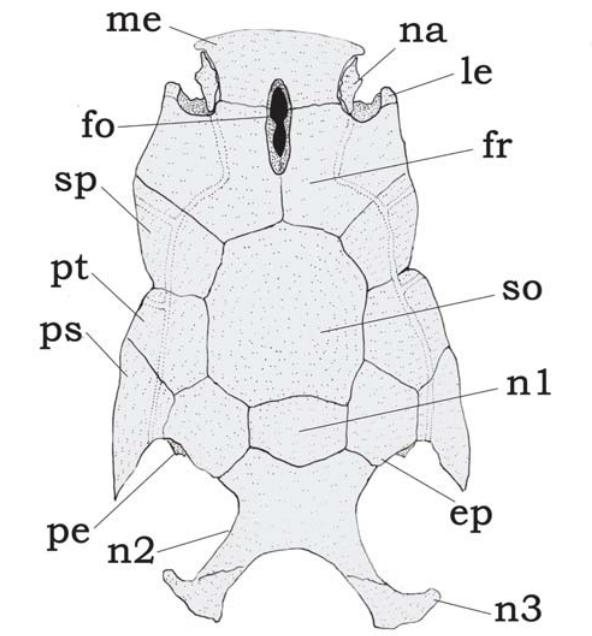
Fig. 37. Neurocranium of Tatia nigra , MNRJ 32024, 97.0 mm SL. Dorsal view. Abbreviations: ep , epioccipital; fo , single cra- nial fontanel, fr , frontal; le , lateral ethmoid; me , mesethmoid; na , nasal; n1 , first nuchal plate, n2 ; second nuchal plate; n3 , third nuchal plate; pe , posterior epioccipital process; ps , posttemporal-supracleithrum; pt , pterotic; so , supraoccipital; sp , sphenotic. Scale bar = 1